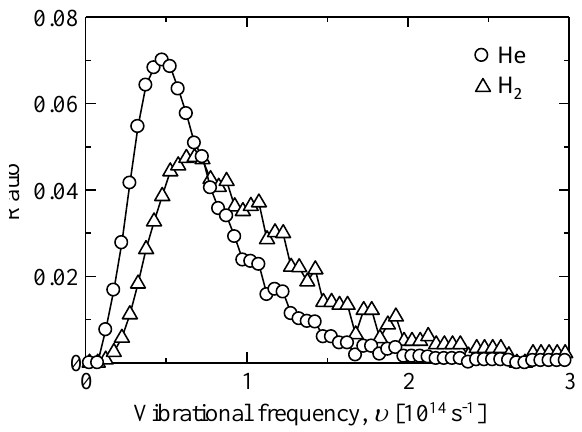
Figure 12. Vibrational frequency distribution of gas molecules trapped in the sorption sites (cage) of an amorphous silica structure.